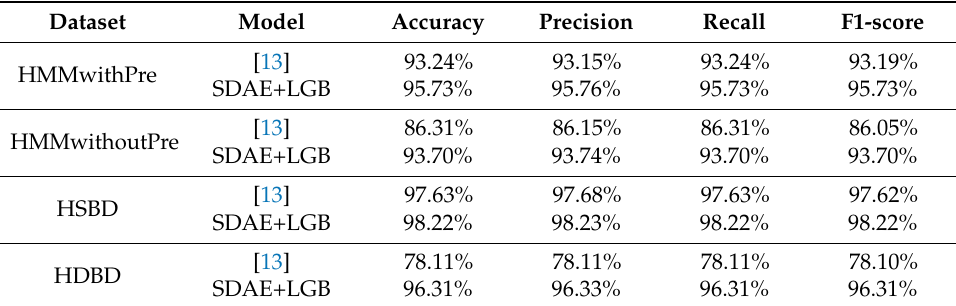
Table 12. The comparison of evaluation score of [13] on four